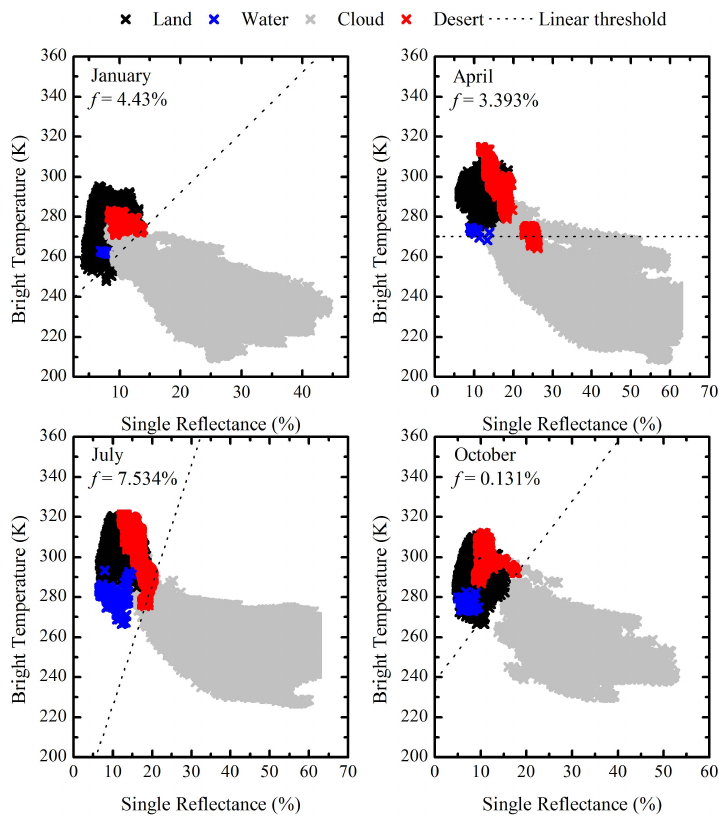
Fig. 4. The scatter diagrams and linear thresholds for channel 4 (10.3–11.3µm) and channel 7 (0.43–0.48µm) during four seasons.